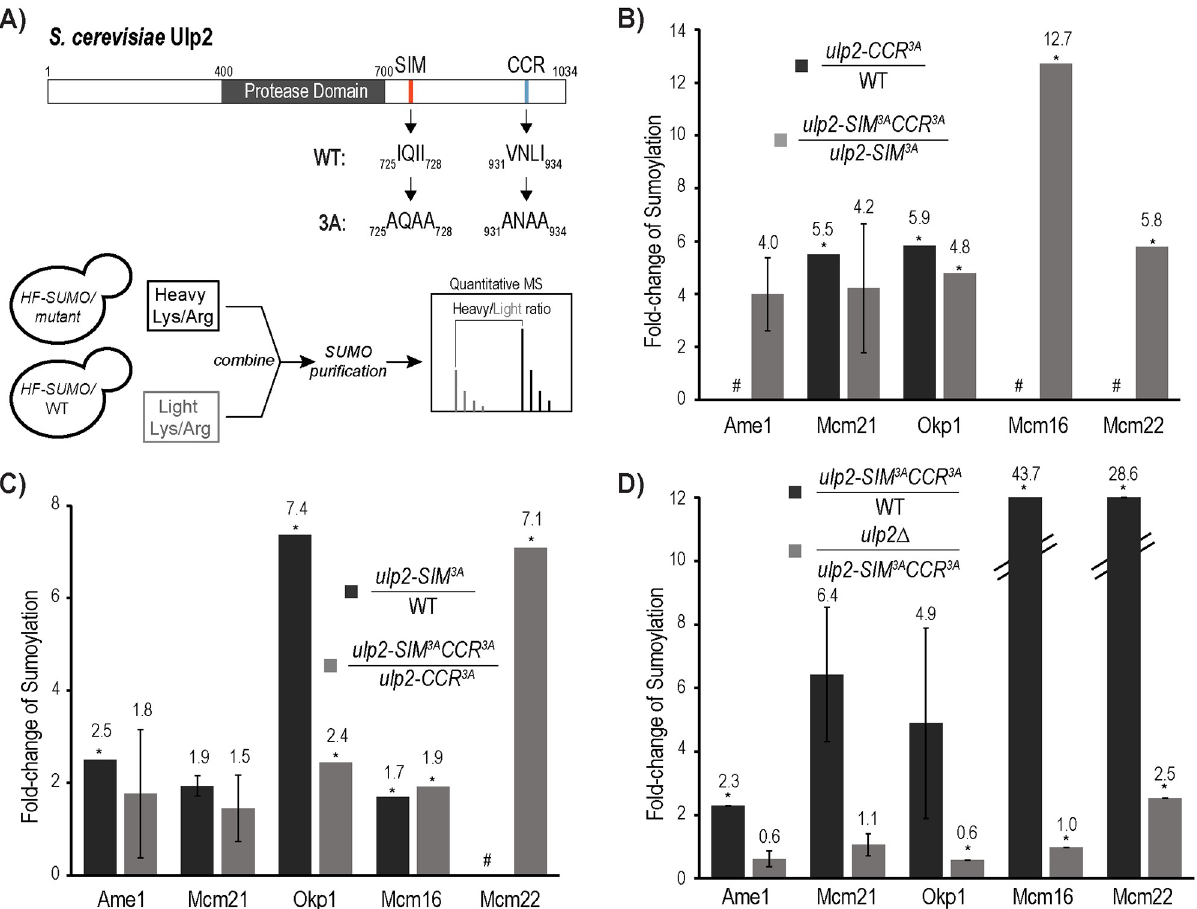
Fig 1. The C-terminal Conserved Region (CCR) and SUMO-interacting motif (SIM) of Ulp2 are both needed to desumoylate the CCAN complex. A) Illustration depicting Ulp2’s domain structure and the quantitative MS approach used to determine the effect of various ulp2 mutations on sumoylated CCAN in the HF-SMT3 (6 × His-3 × FLAG-Smt3) strain background (see experimental methods for details). Conserved hydrophobic residues in Ulp2’s SIM and CCR are indicated. Triple alanine mutations of these residues generate the ulp2-SIM 3A and ulp2-CCR 3A mutants. B-D) Effects of various ulp2 mutations on sumoylated CCAN subunits are shown, while the rest of the MS results can be found in S1–S6 Tables. In each case, the fold-changes in the sumoylated CCAN subunit are shown for each of the indicated strains. CCAN subunits not identified in the MS experiments are indicated by #. Asterisks ( � ) indicate where an insufficient number of peptides are available for statistical